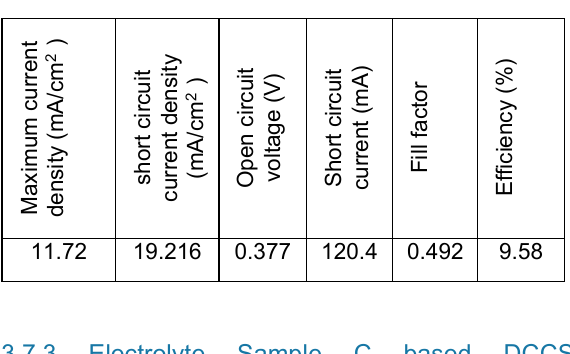
Table 5. Performance parameters of sample B